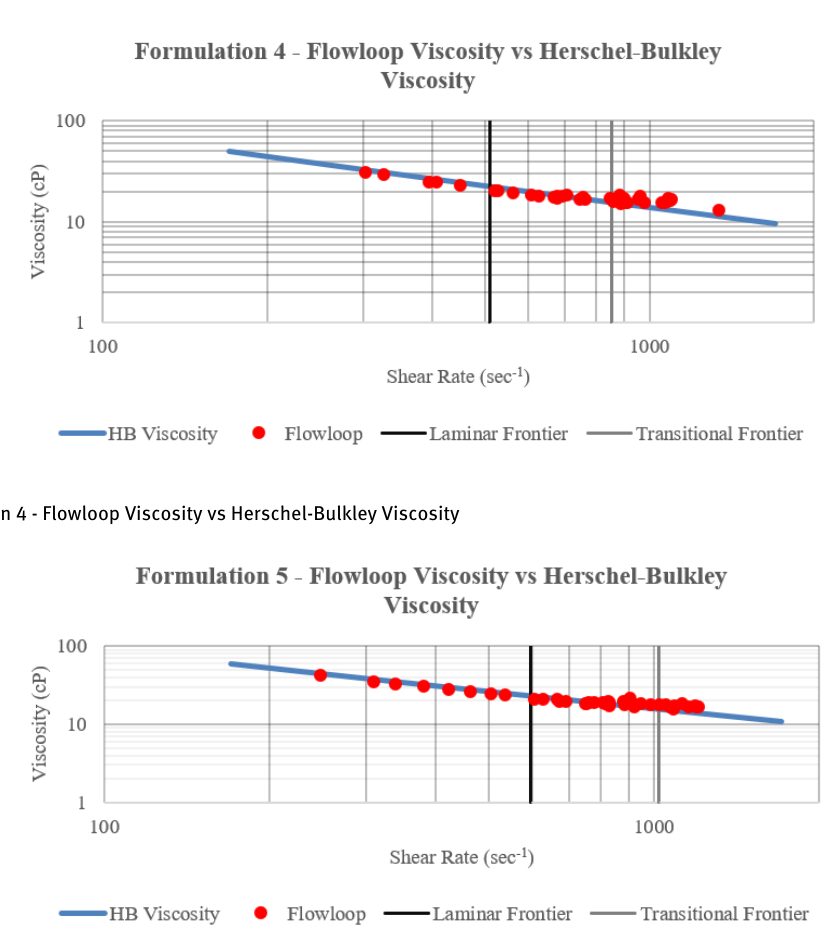
Figure 15: Formulation 5 - Flowloop Viscosity vs Herschel-Bulkley